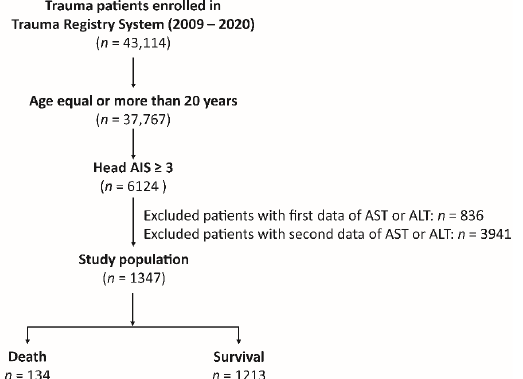
Figure 1. Flowchart illustrating the inclusion of hospitalized adult trauma patients with moderate-to-severe traumatic brain injuries from the registered trauma database. Those patients who lacked the first AST or ALT data upon arrival at the emergency room and at 72–96 h later, were excluded from the study population.